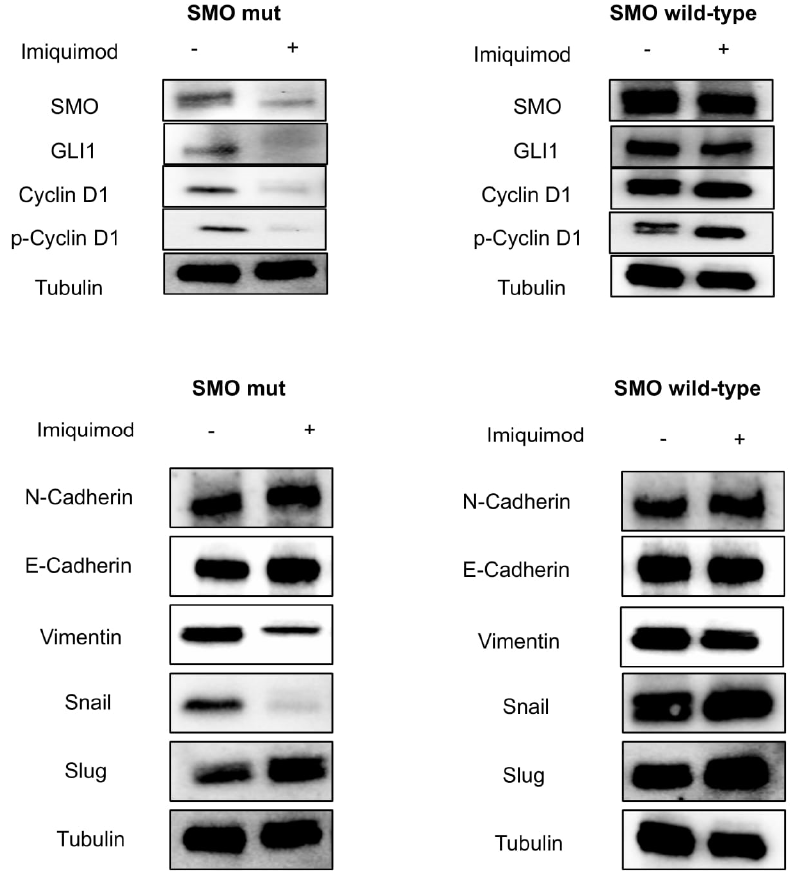
Figure 6. Tumor samples were collected, and total cell protein extracts were subjected to im- munoblotting with the indicated antibodies (bar graphs in Supplementary Figure 4), as described in Materials and Methods. Anti-tubulin antibody was used for normalization of protein extract